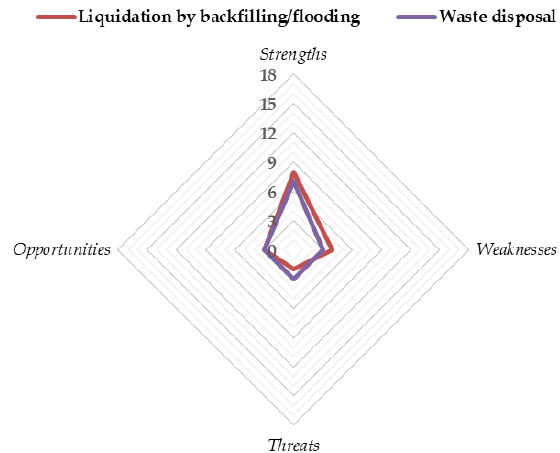
Figure 9. The quantitative results of SWOT analysis for reclamation methods aimed at permanent liquidation of underground workings.